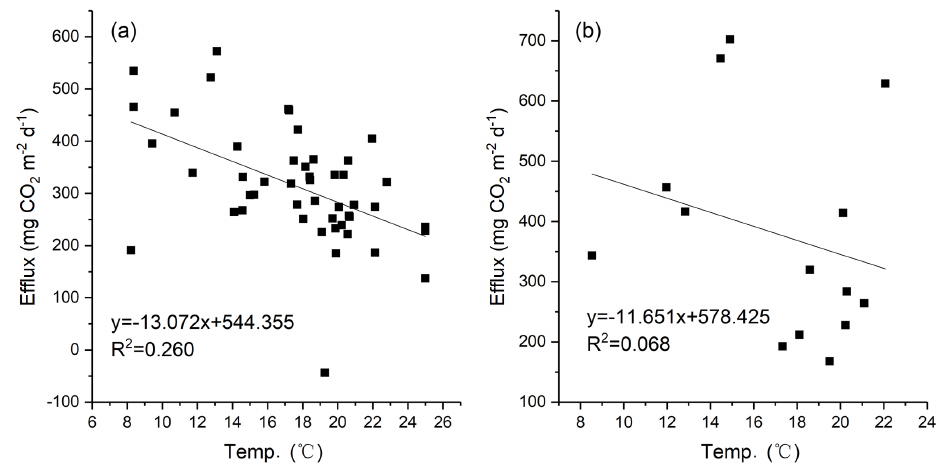
Figure 8. Negative correlations between water temperature and effluxes in the pelagic zone ( a , p < 0 . 01) and in the littoral zone ( b , p > 0 . 05). Notice that two extreme values were excluded in the linear regression in panel (b) .